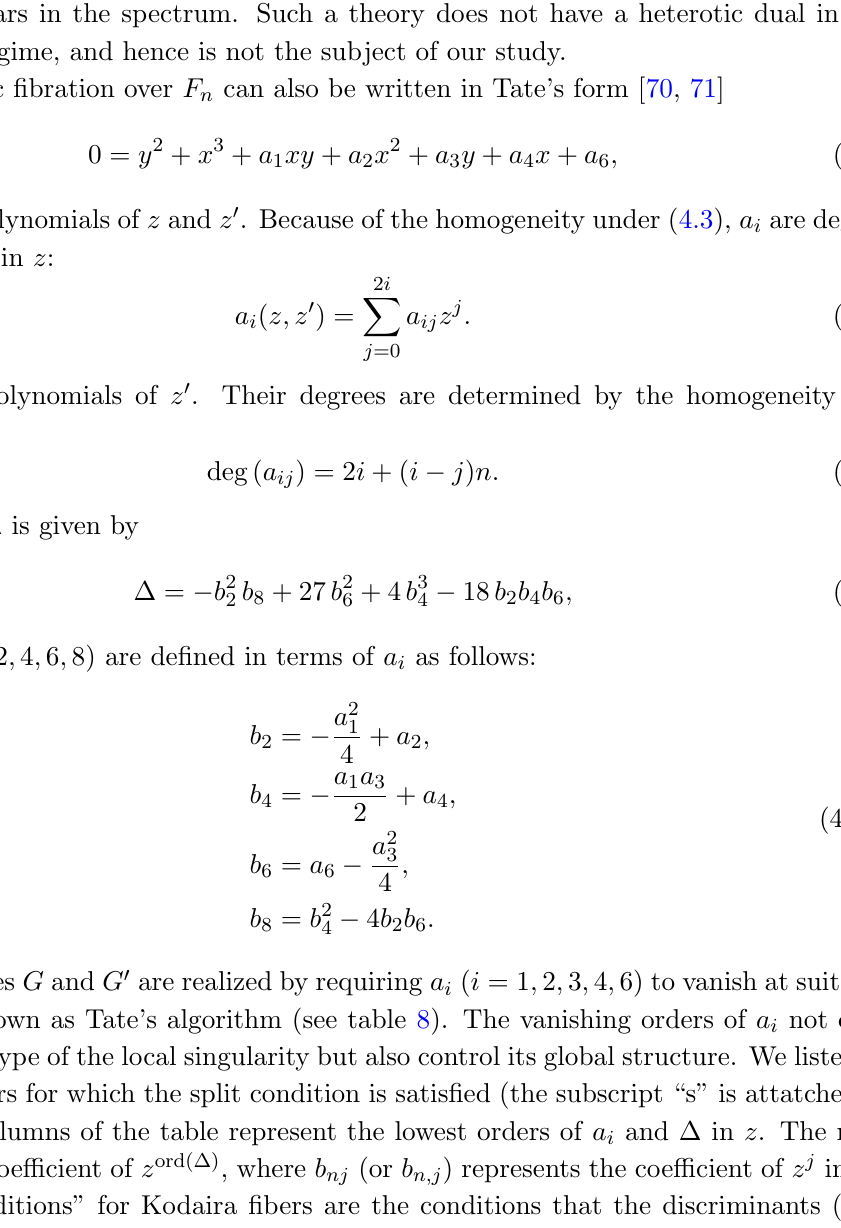
and (cid:1) in z . The next i (or b ) represents the coe(cid:14)cient of z j in b nj n;j n